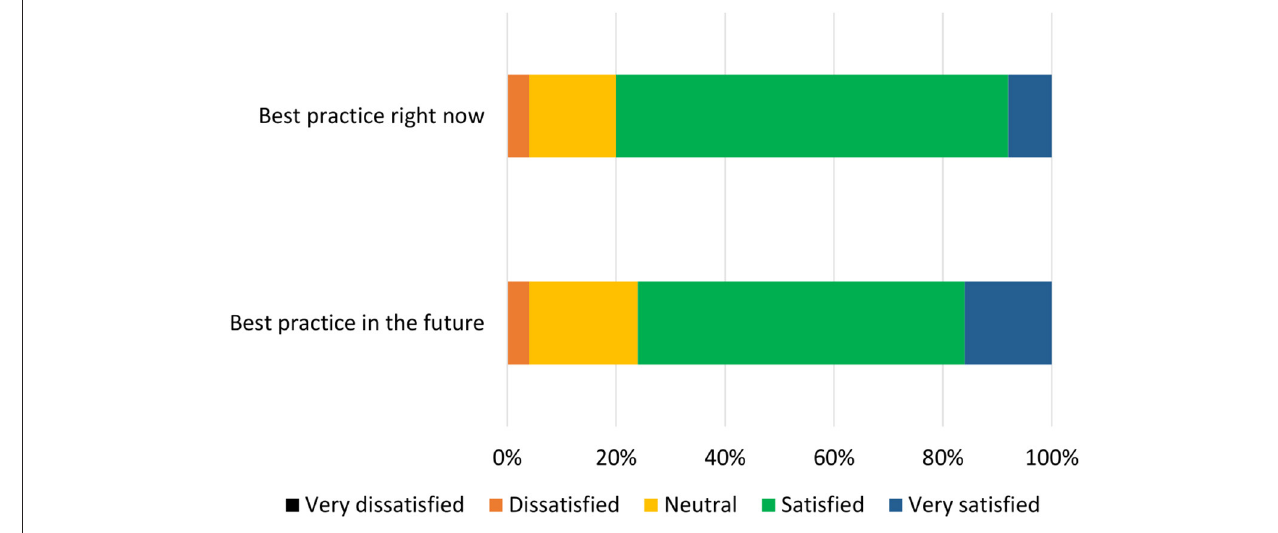
FIGURE 4 | Participant satisfaction with the draft checklist during Phase 2 ( n = 25).